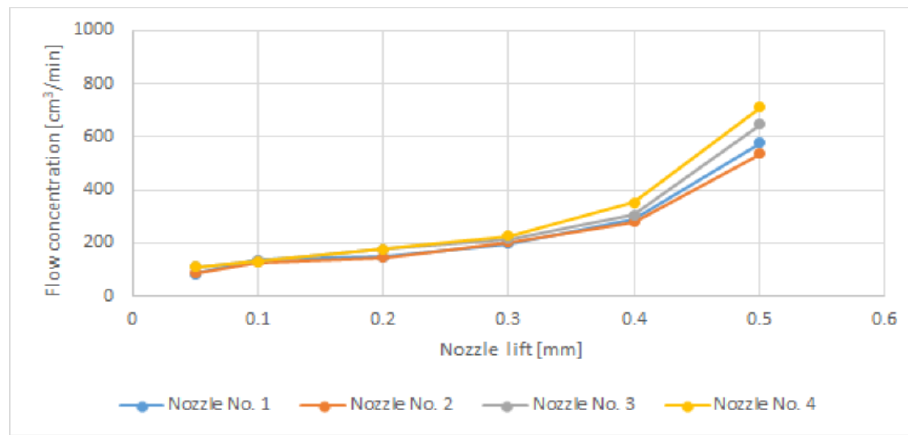
Figure 12. The flow after the test for SD3.